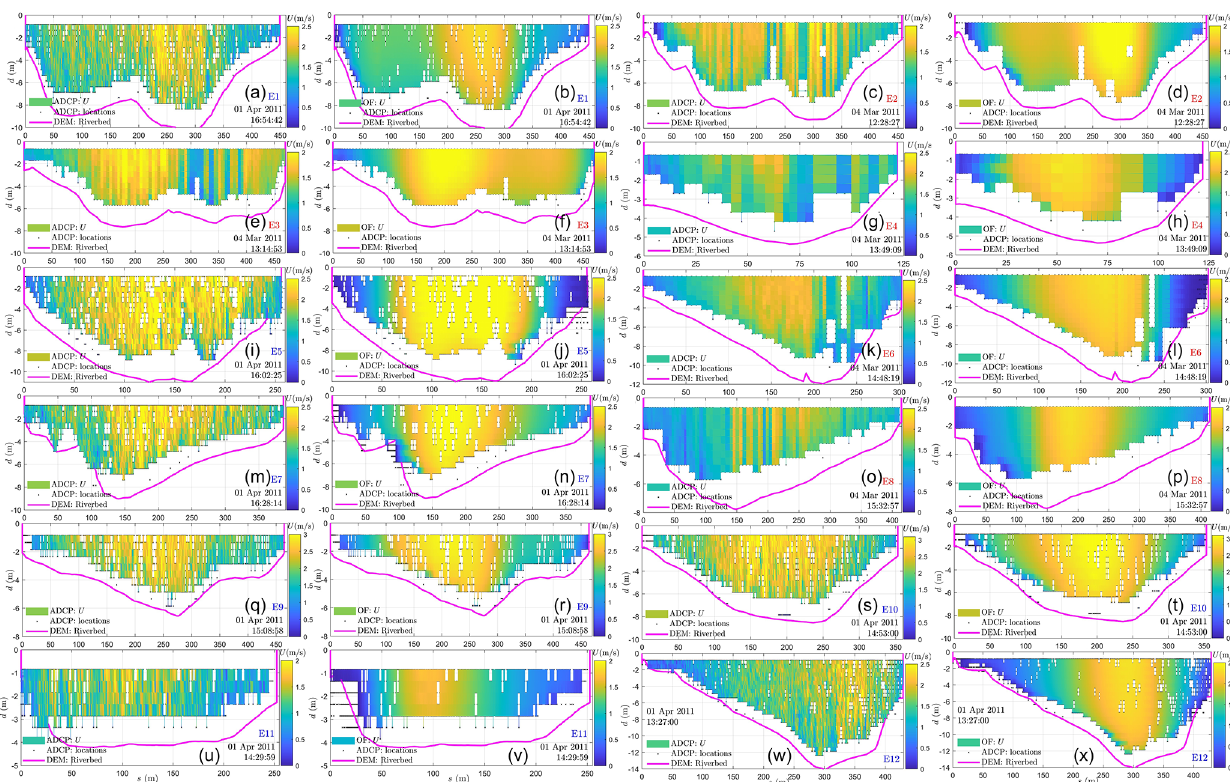
Figure 7. The velocity magnitude distributions on cross sections E1–E12 from ADCP surveys (columns 1 and 3) and CFD modeling (columns 2 and 4). Cross-section names (E1–E12) with red and blue color denote survey dates on 4 March and 1 April 2011, respectively. Symbols d and s denote depth away from the water surface and distance from the right bank (see Fig. 1c),